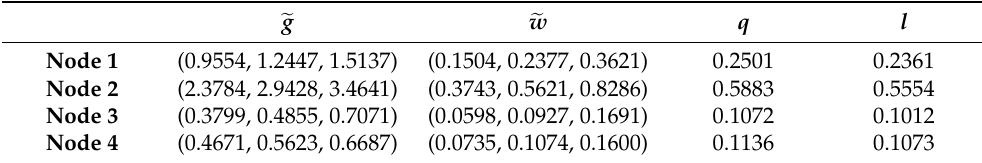
Table A8. Geometric mean ( (cid:101) g ) and weights ( (cid:101) w , q , l ) for No. hops criterion.